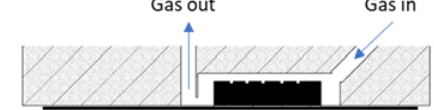
Figure 6. Gas flow through the sensor